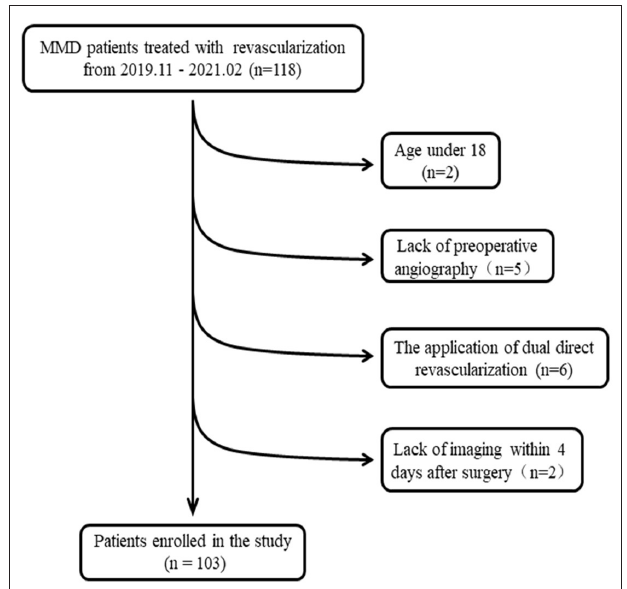
FIGURE 1 | Flow diagram for the study selection